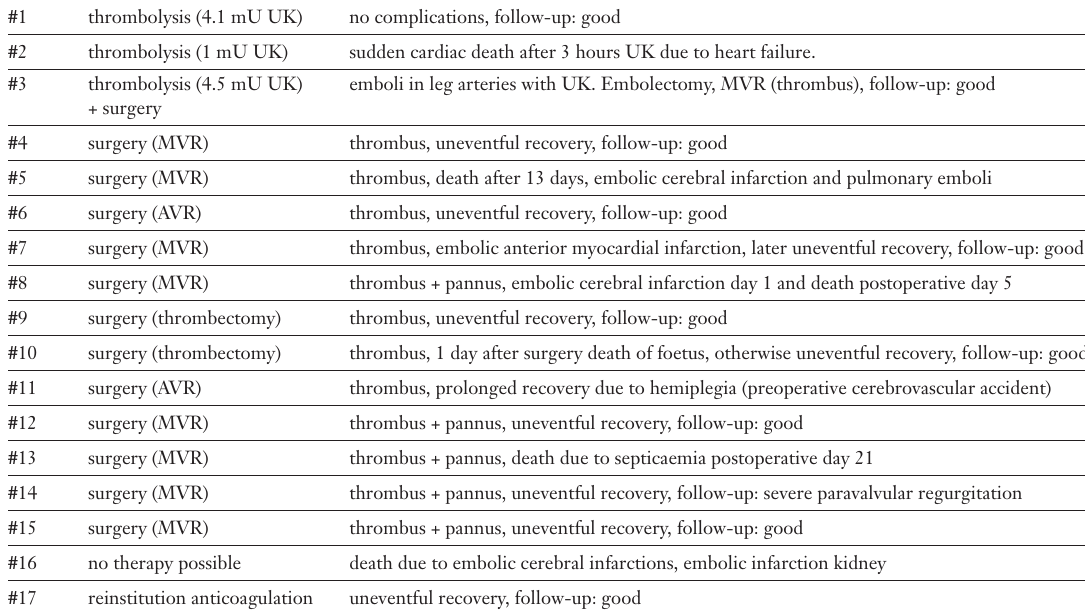
Table 3 Treatment and outcome in patients with prosthetic valve thrombosis. CM = CarboMedics; mU = million units; UK = urokinase; MVR = repeat mitral valve replacement; AVR = repeat aortic valve